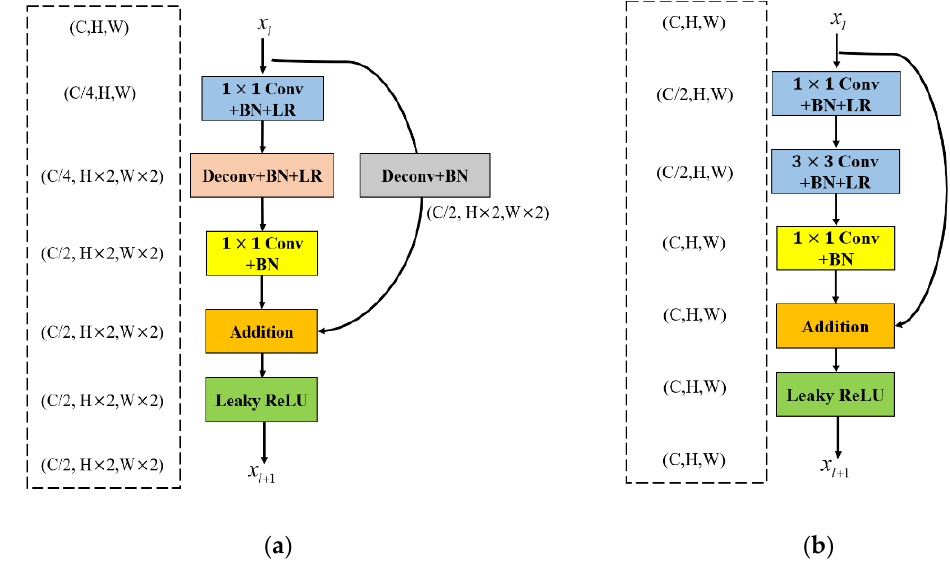
Figure 3. Residual structure in generator. ( a ) “ResBlock Upsample” block. ( b ) Traditional residual block.